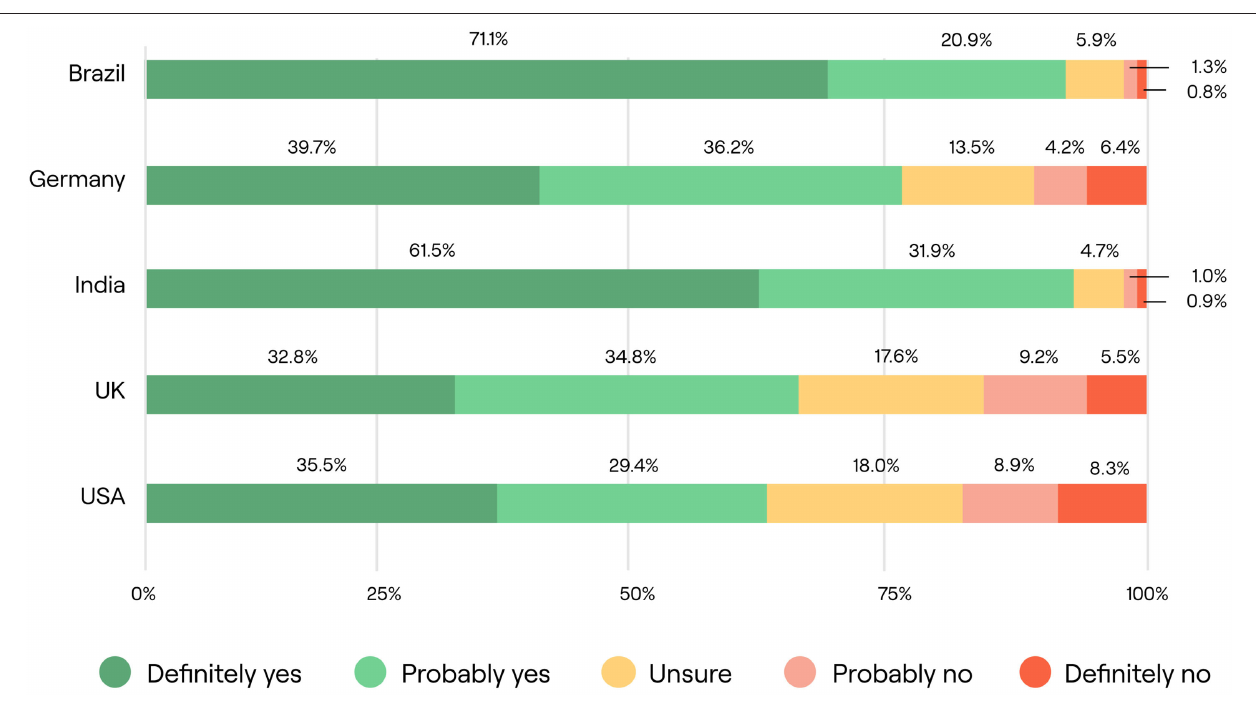
from the animal-free dairy product. The coloured lines represent the perceptions from across the five different